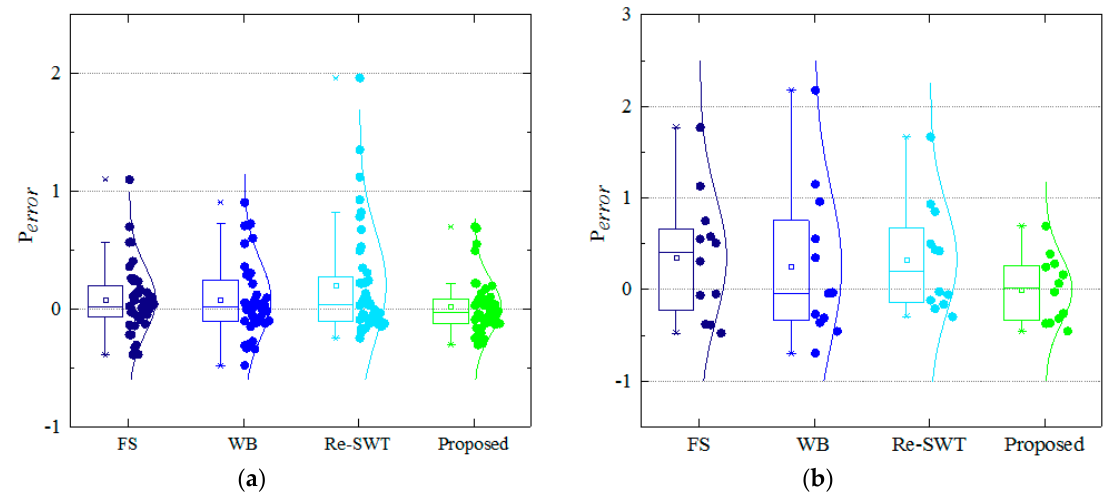
Figure 9. Estimation errors of TC4 under symmetric and asymmetric loadings: ( a ) TC4 under symmetric loading; ( b ) TC4 under asymmetric loadings.